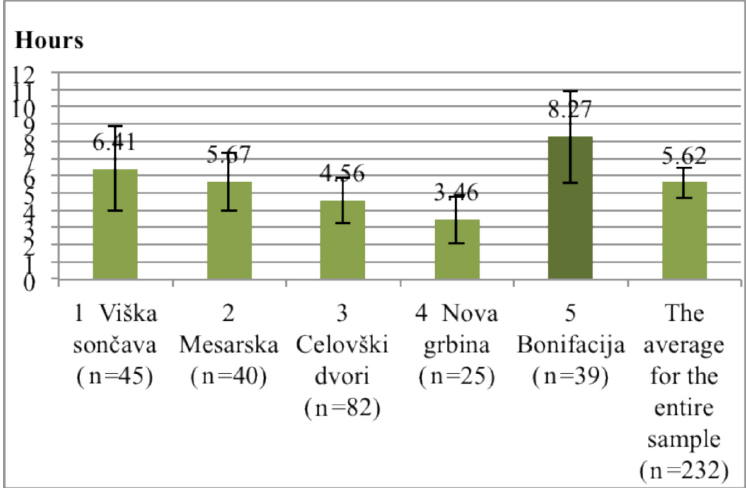
Figure 5. Time in hours per week that children spend playing outdoors (95% Confidence Interval of the